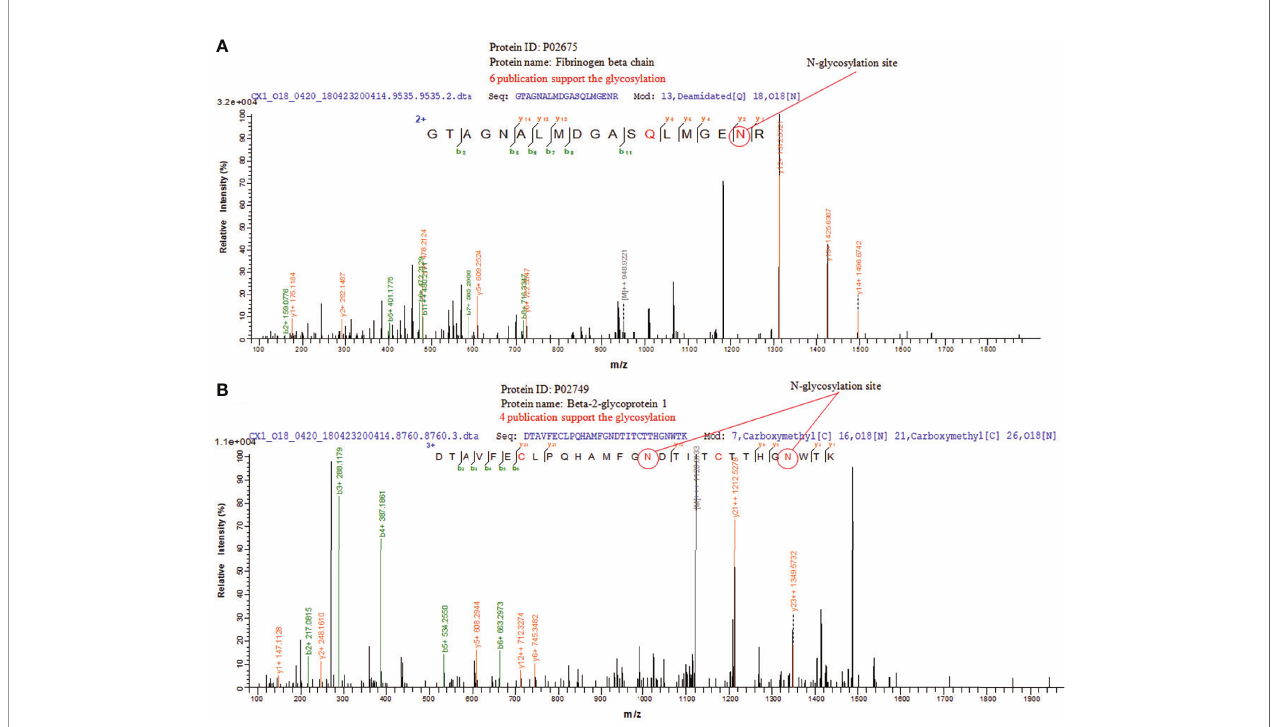
FIGURE 5 | LC-MS/MS of N-glycosylations site of glycoproteins in CRC tissue exosomes. (A) Fibrinogen beta chain and (B) beta-2-glycoprotein